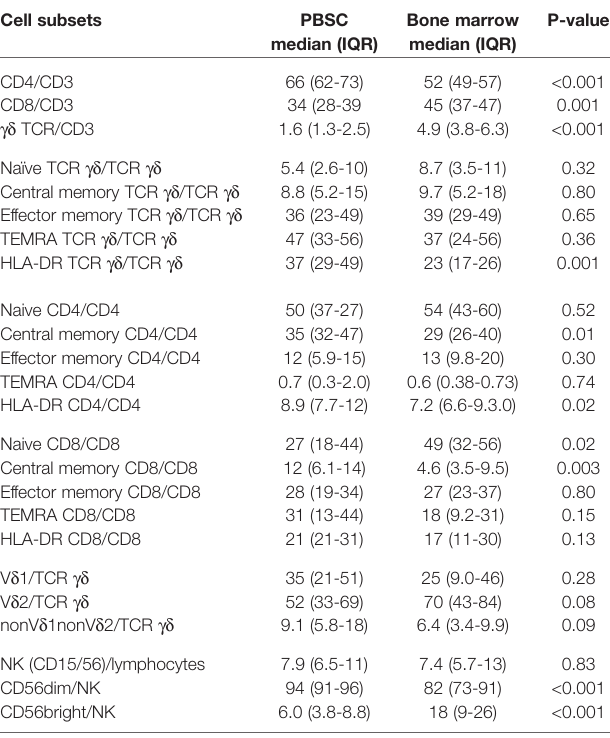
TABLE 4 | NK and T cell subset distribution (percent) in stem cell grafts from peripheral blood stem cells (PBSC), n=17, and bone marrow, n=14. Cell subsets PBSC median (IQR)